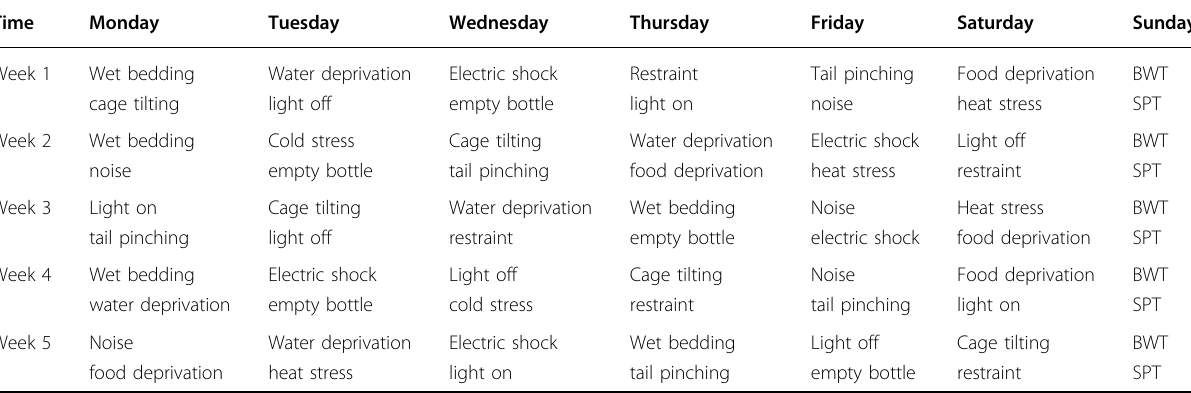
Table 1 The schedule of CUS model